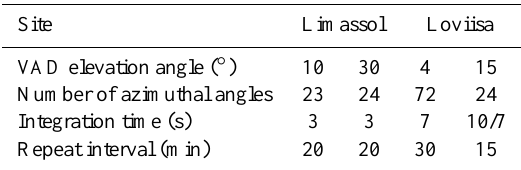
Table 2. Scan settings at Limassol and Loviisa. At Loviisa the 15 ◦ elevation angle VAD integration time was decreased from 10 to 7s on 11 February